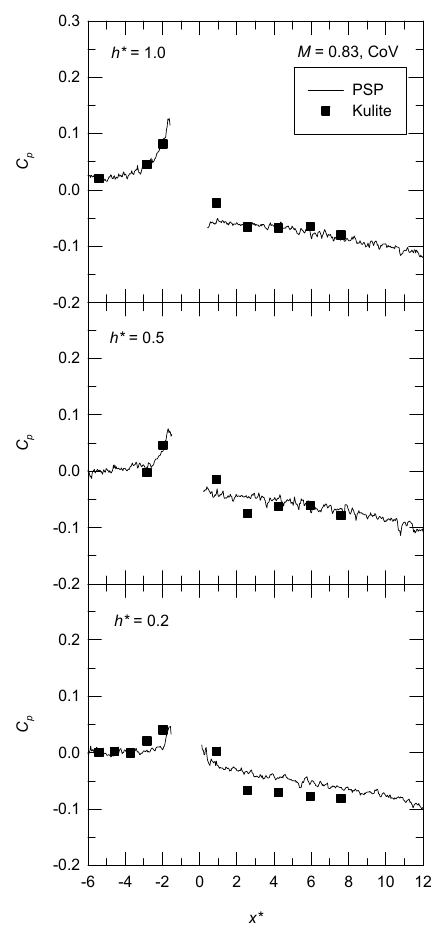
Figure 9. The e ff ect of CoV VG on the centerline surface pressure distribution for M = 0.83. Figure 9. The effect of CoV VG on the centerline surface pressure distribution for M = 0.83. The drag penalty for VGs is defined in terms of the upstream peak mean surface pressure, C p,max . The data for M = 0.64 and 0.83 are shown in Figure 10. The Kulite measurements (solid symbols) show that for CRV and CoV VGs, there is an increase in the value of C p,max as h* increases, but not for Ramp VGs. This is due to the spatial resolution of the discrete pressure taps. The PSP data (hollow symbols) show the effect of h* on the value of C p,max . Conventional VGs ( h* = 1.0) result in an increase in value of C p,max more significantly than MVGs ( h* = 0.2 and 0.5). The effect is particularly noticeable for CRV and Ramp VGs. This is a factor in quantifying the overall performance of VGs for BLS